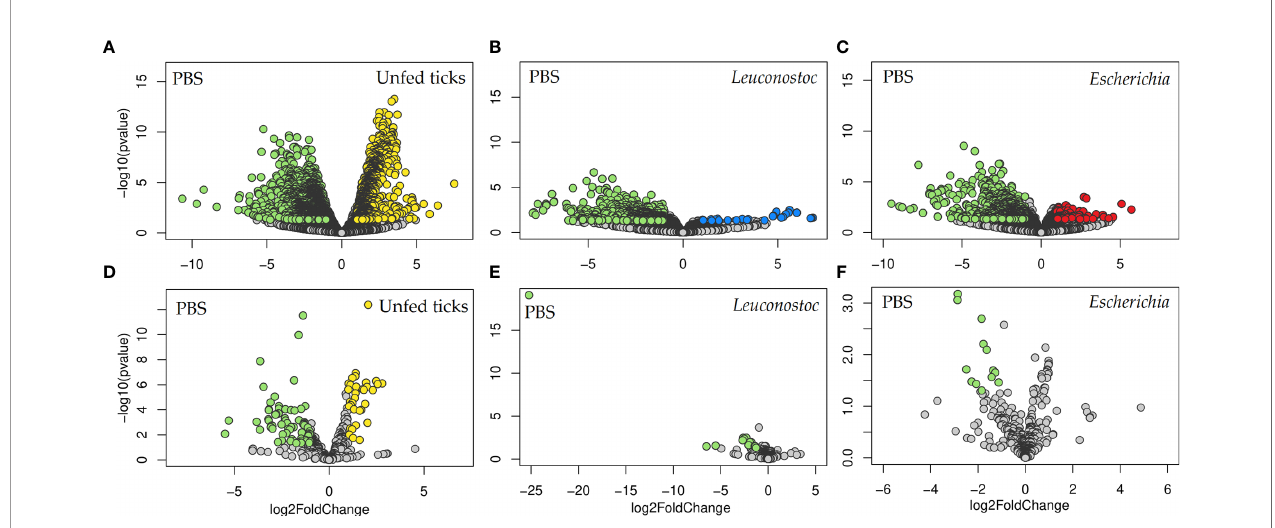
FIGURE 8 | Impact of anti-microbiota vaccines on the predicted functional pro fi les of tick microbiome. Volcano plot showing differential enzyme (A – C) and pathway (D – F) abundance in ticks of the different groups: (A, D) unfed ticks vs. ticks fed on mock-immunized mice (PBS), (B, E) ticks fed on mock-immunized vs. L. mesenteroides -immunized mice, and (C, F) ticks fed on mock-immunized vs. E. coli -immunized mice. The yellow (unfed ticks), blue (ticks fed on L. mesenteroides - immunized mice), and red (ticks fed on E. coli -immunized mice) dots indicate enzyme (A – C) and pathway (D – F) that displayed both large magnitude fold-changes and high statistical signi fi cance favoring disturbed or control PBS group (green dots), while the gray dots are considered as not signi fi cant. Differential features were detected by the DeSeq2 algorithm (Wald test, p < 0.05). The functional pro fi les were predicted from 16S rRNA sequences obtained from samples of unfed I. ricinus nymphs (n = 6 tick pools), and nymphs engorged on E. coli -immunized (n = 9 tick pools), L. mesenteroides -immunized (n = 5 tick pools), or mock-immunized (n = 7 tick pools) mice.